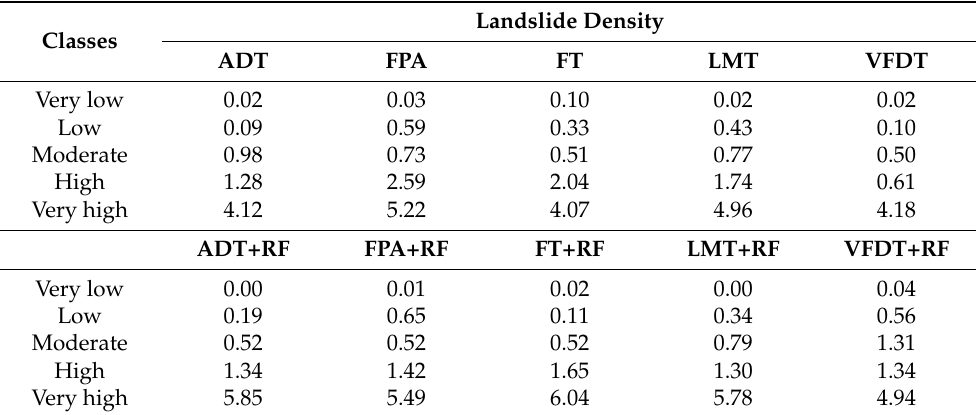
Table 3. Landslide density of different susceptibility maps.